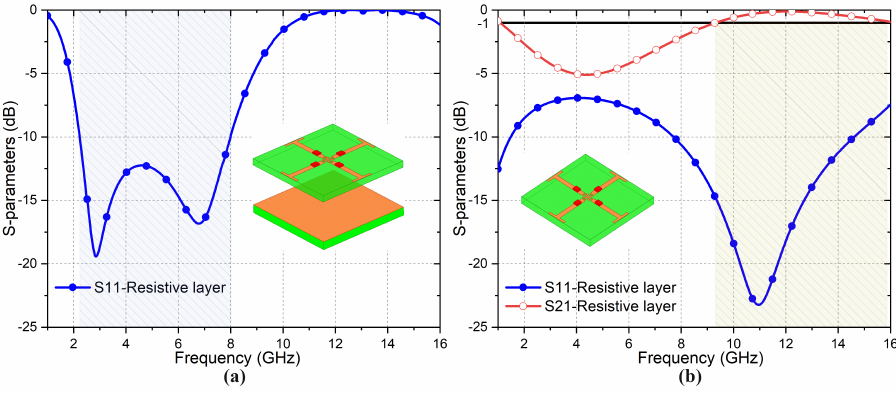
Figure 4. Scattering parameters of resistive layer: ( a ) absorption performance with a ground plane; ( b ) transmission/reflection coefficients of resistive layer without a ground